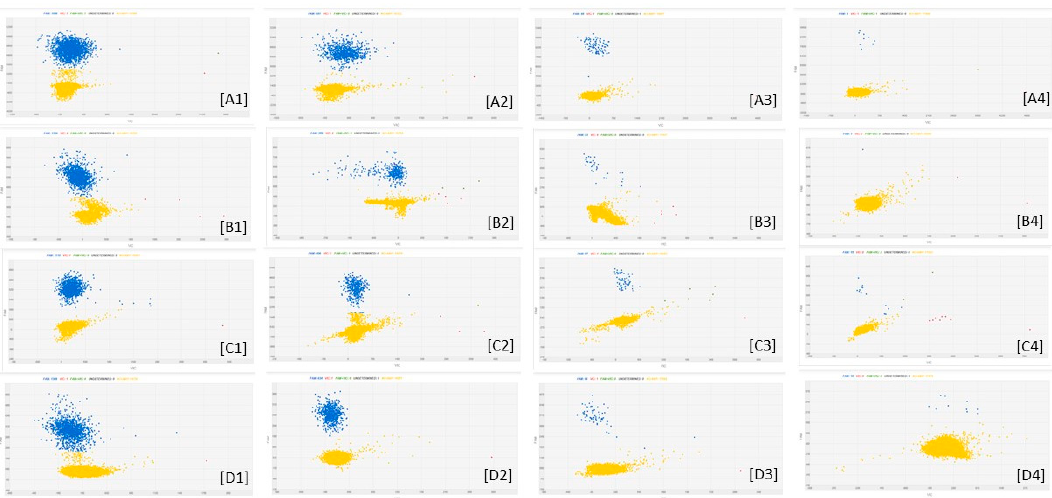
Figure 2. cdPCR amplification plots of Fusarium DNA dilutions. The letters indicate the different fungal species: [ A ] = F. poae ; [ B ] = F. sporotrichioides ; [ C ] = F. graminearum ; [ D ] = F. avenaceum . The numbers indicate the dilutions factors: 1 means 0.25 ng of fungal DNA as Qubit quantified; 2 means sample 1 diluted 2.5 times; 3 means sample 2 diluted 10 times; 4 means sample 3 diluted 10 times. The blue dots are the PCR partitions resulted positive to amplification of the target; the yellow dots are the PCR partitions negative to amplification of the target.